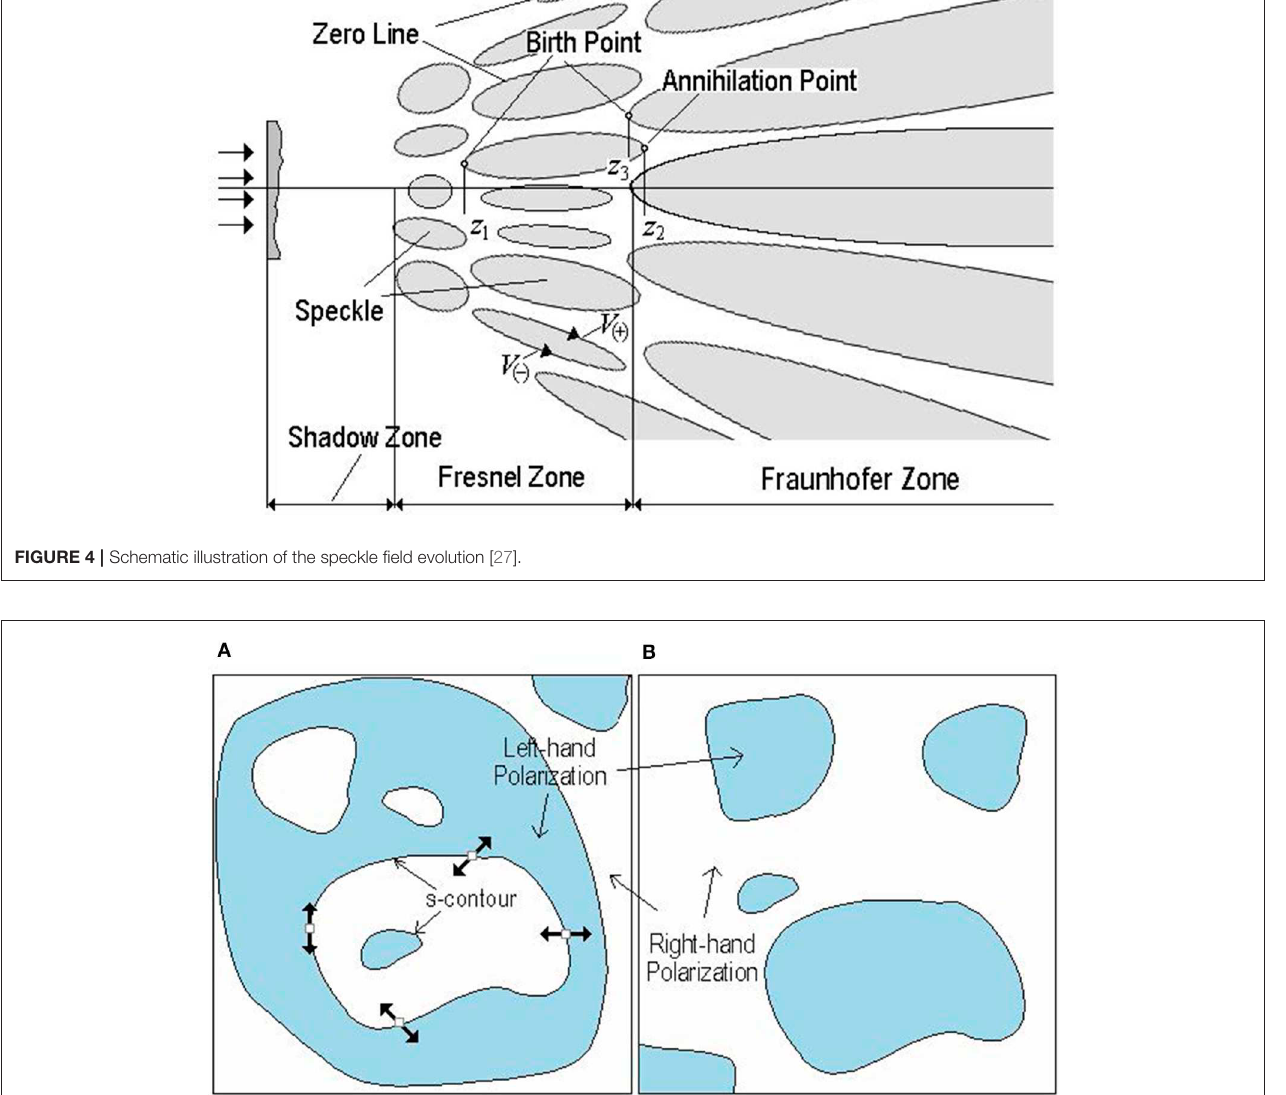
FIGURE 5 | Different types of the s -contour structure [27]. (A) hierarchy of enclosed areas with alternating polarizations; (B) isolated areas (“islands”) of one polarization surrounded by the “sea” of the opposite